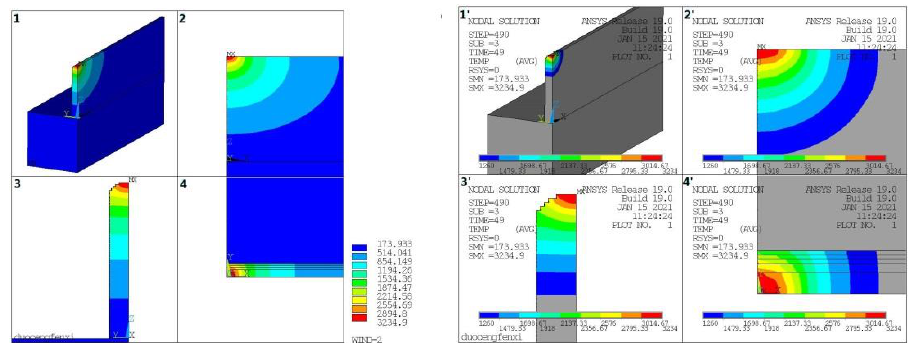
Figure 7. Simulation results of laser cladding temperature field and molten pool temperature field distribution: 1—three-dimensional diagram, 2—front view, 3—side view, 4—planform.